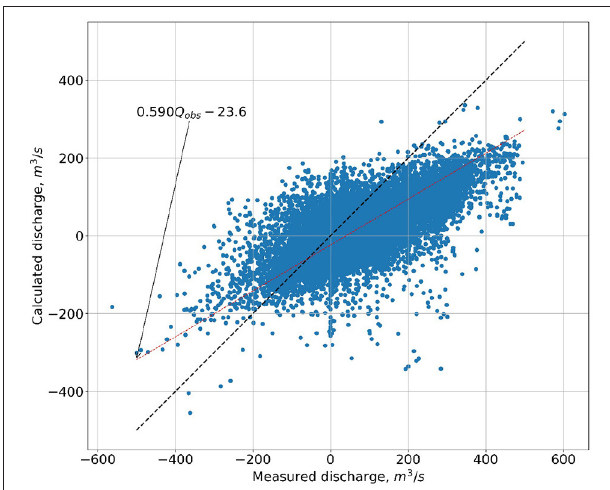
FIGURE 8 | Calculated vs. observed discharge in the Trade channel.